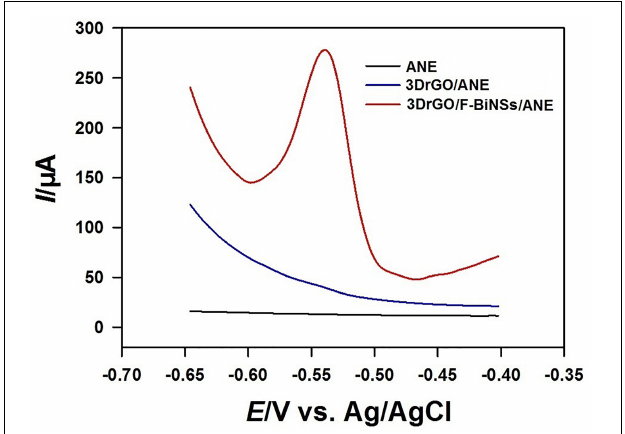
FIGURE 6 | Square wave voltammograms of the bare ANE, 3DrGO/ANE, and 3DrGO/F-BiNSs/ANE in 0.1 mol L − 1 acetate buffer (pH 3.5) solution containing 1 µ mol L − 1 Pb 2 + .